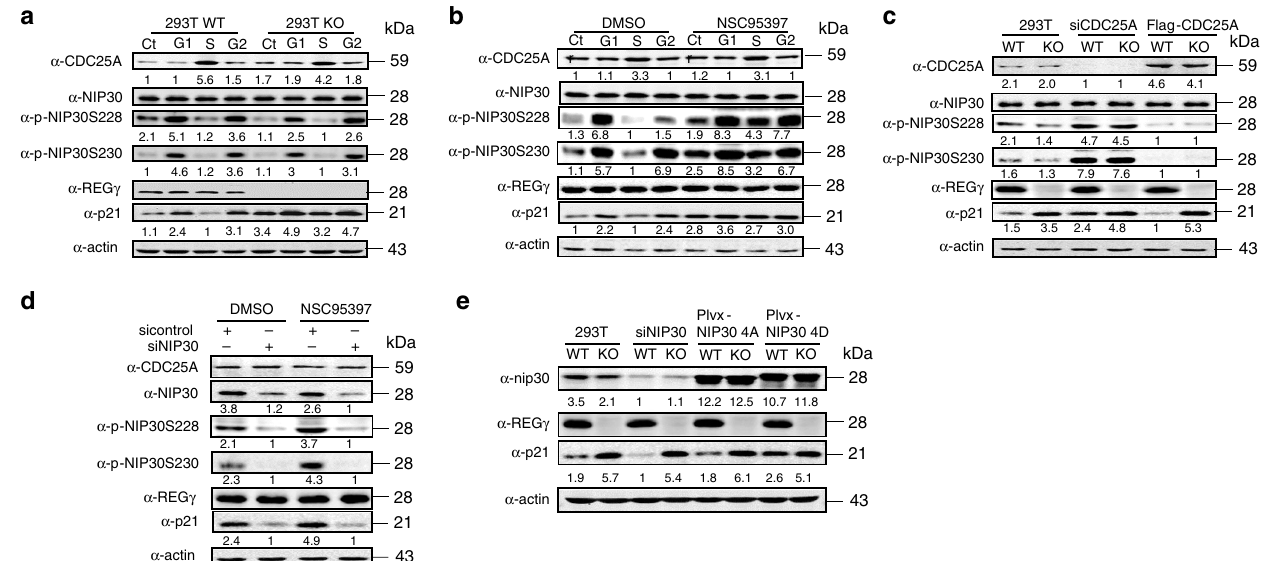
Fig. 4 The CDC25A – NIP30-REG γ pathway regulates p21 during the cell cycle. a , REG γ WT and 293T KO cells were synchronized to the G0/G1, S, and G2/M phases. Cell lysates were subjected to western blot analysis with indicated antibodies. Data are representative of at least three independent experiments. b Synchronized REG γ WT and KO 293T cells were treated with NSC95397 for 3 h. Cell lysates were subjected to western blot analysis. Data represent mean ± SEM from three independent experiments. c REG γ WT and KO 293T cells were transfected with an siRNA speci fi c for CDC25A or fl ag- CDC25A for 72 h. Cells synchronized in the S phase were collected for western blot analysis. Data represent mean ± SEM from three independent experiments. d 293T cells were transfected with a short interfering RNA (-si) for NIP30 or an si control for 72 h. Cells arrested at the S phase were collected for western blot analysis in three independent experiments. Data represent mean ± SEM. e REG γ WT and KO 293T cells were transfected with indicated short interfering RNA (-si) for NIP30 or NIP30 4A/4D constructs. Cells synchronized at the S phase were collected for western blots in three independent experiments. Data represent mean ± SEM. Source data are provided in a Source Data fi le.